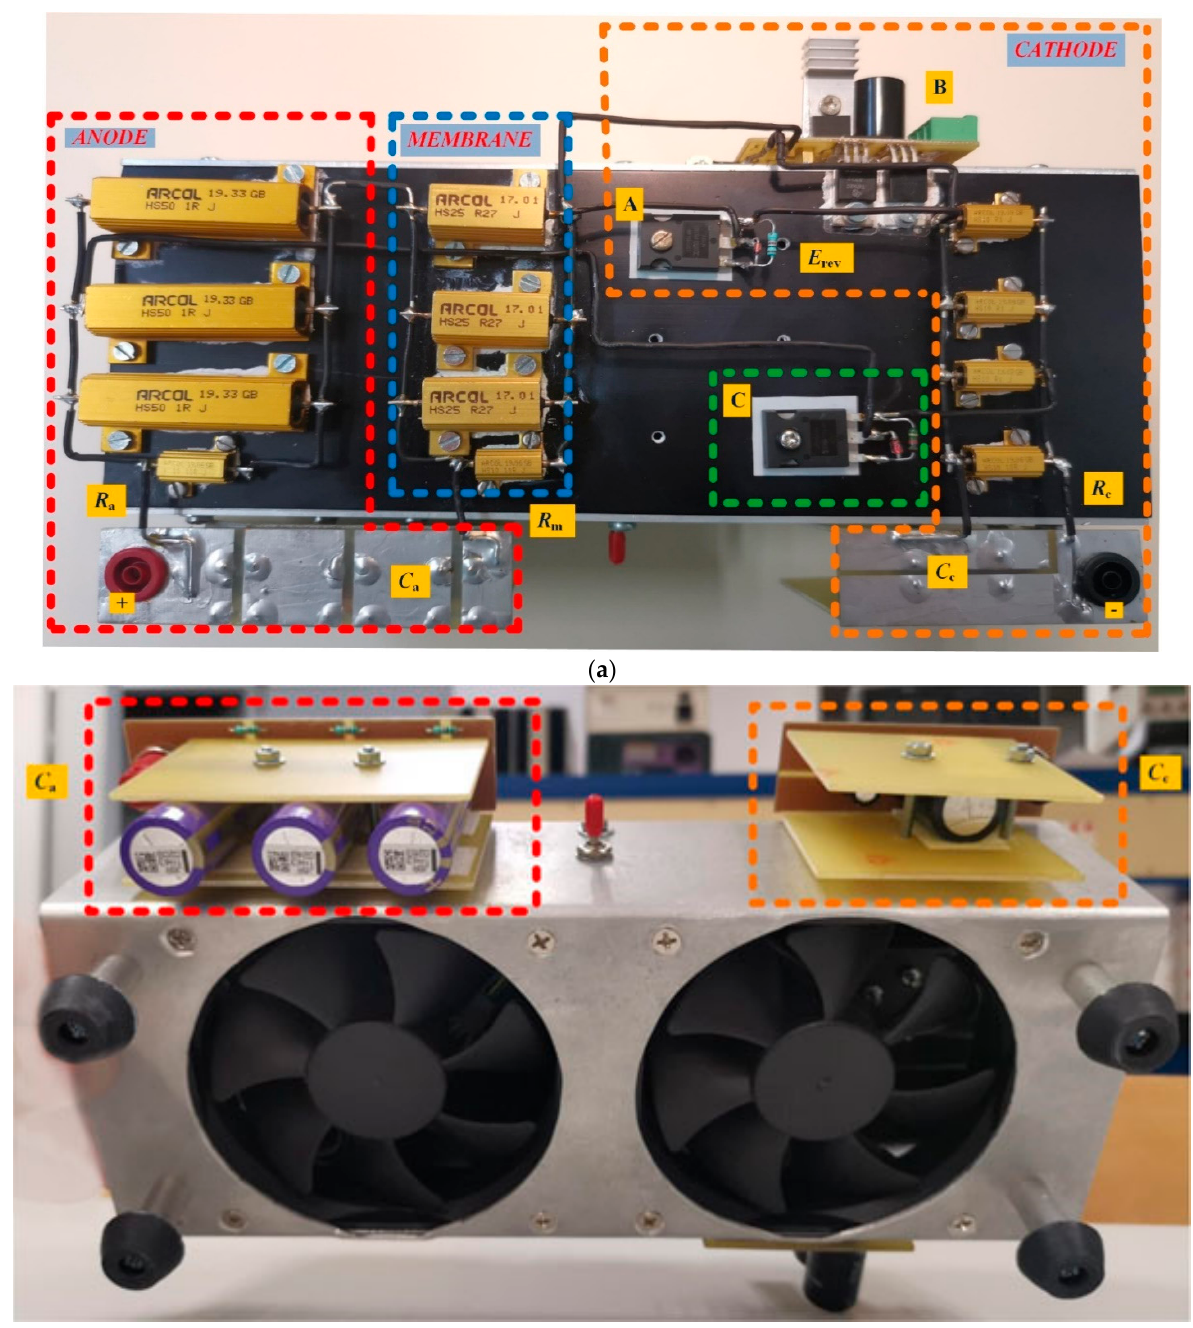
Figure 7. ( a ) Top view of the PEM electrolyzer emulator. ( b ) Side view of the PEM electrolyzer emulator where supercapacitors are visible.